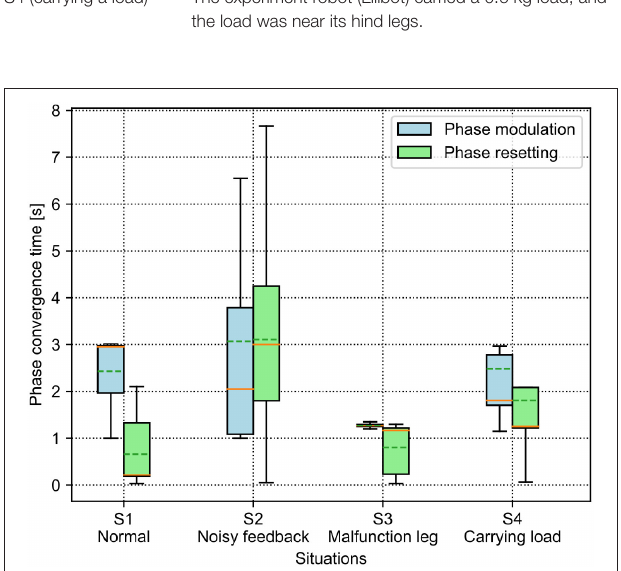
FIGURE 7 | Phase convergence time of the PM and PR in four different situations. The solid and dashed lines in the boxes indicate the median and mean values of the phase convergence time,